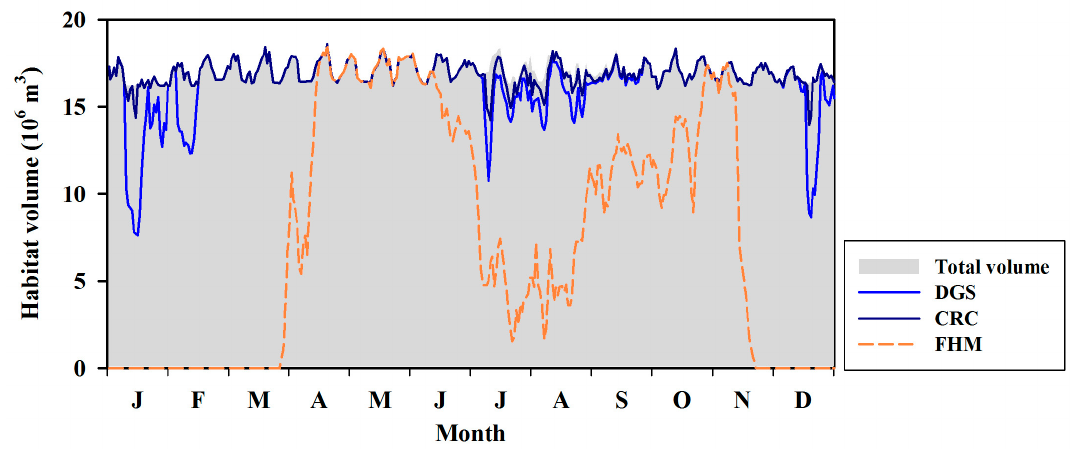
Figure 12. Simulation results of survival habitat volumes for three major fish species of GAW.